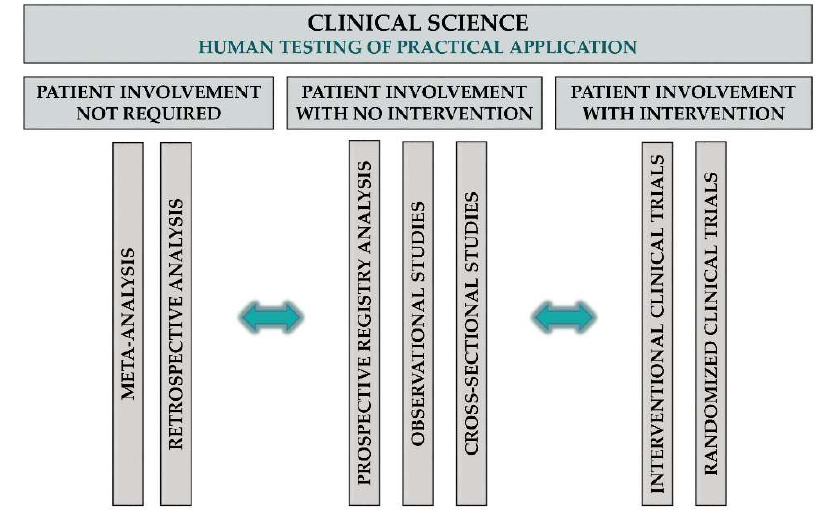
Figure 4. Clinical science in TM.